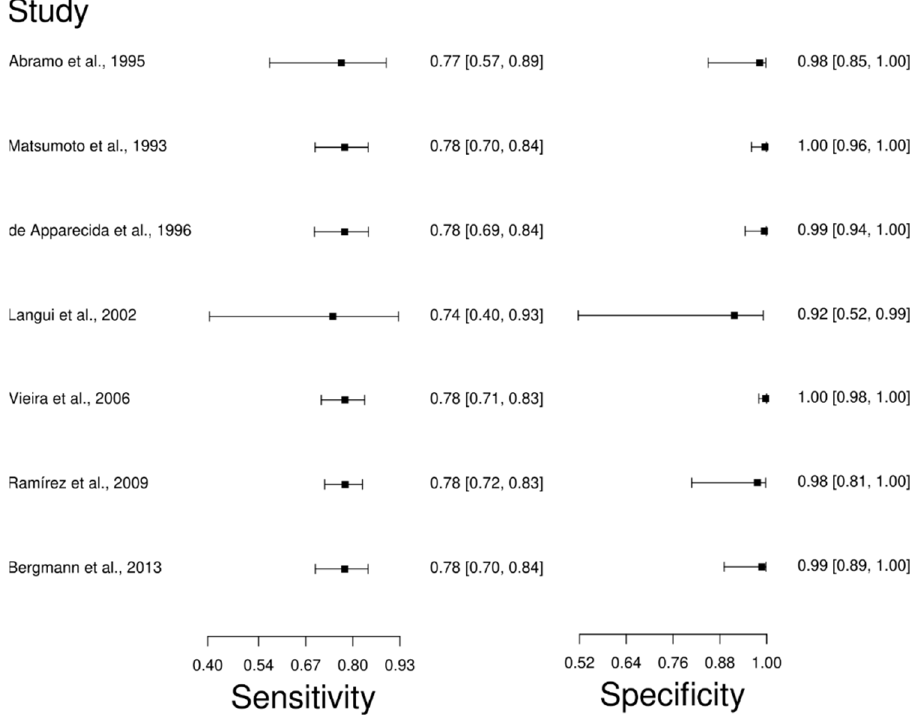
Figure 5. Study data and paired forest plot of the sensitivity and specificity of Fluorescence antibody assay (IFAT) in Chagas’s disease diagnosis. Data from each study are summarized. Sensitivity and specificity are reported with a mean (95% confidence limits). The Forest plot depicts the estimated sensitivity and specificity (black squares) and its 95% confidence limits (horizontal black line) [66,67,80–84].